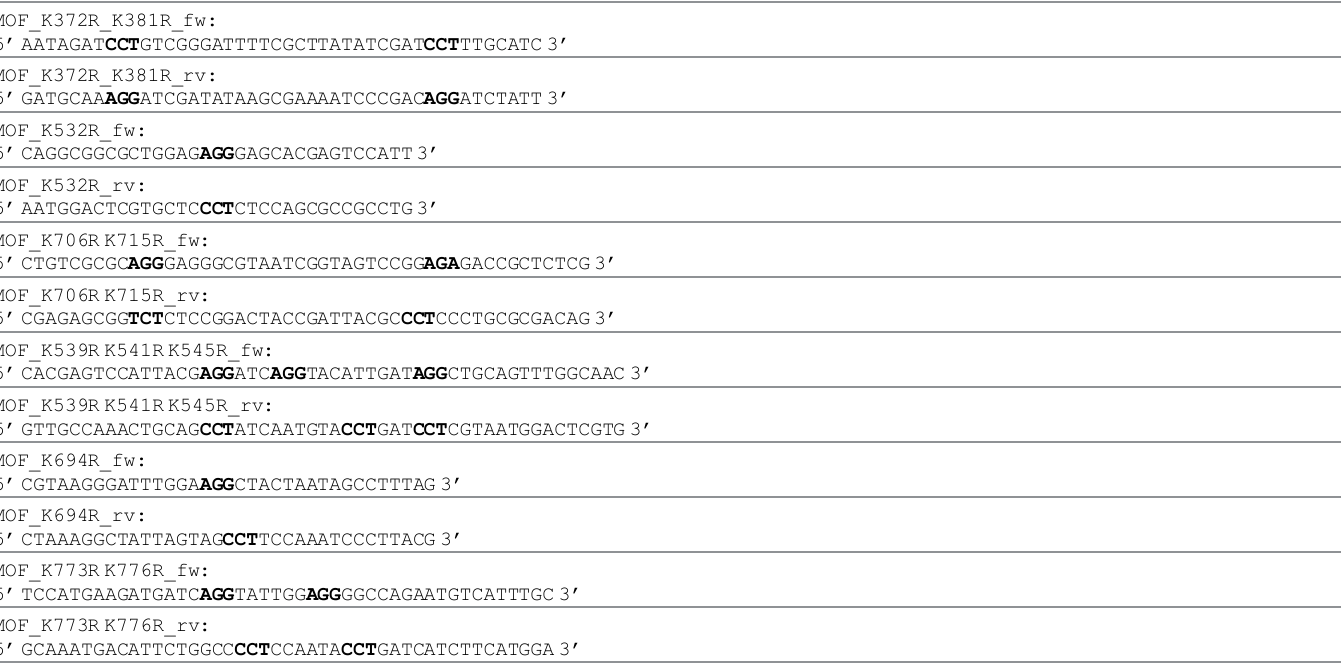
Table 1. Cloning primer for generation of MOF mutant constructs.